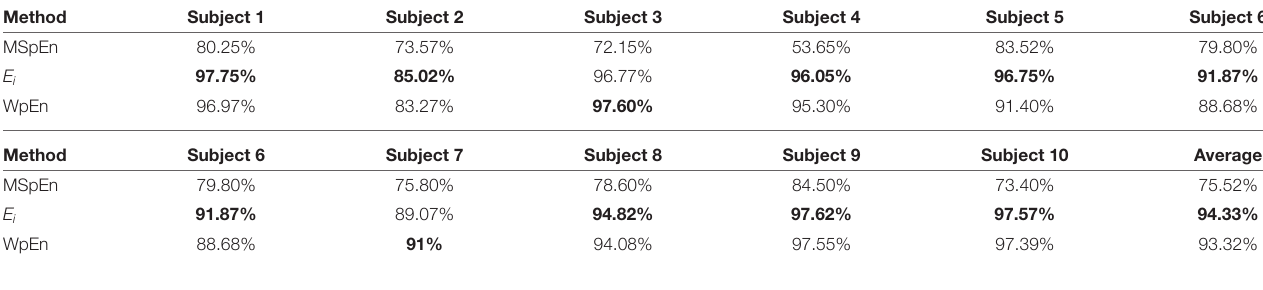
TABLE 2 | Average results of decision tree algorithm with multi-scale sample entropy (MSpEn), wavelet packet entropy (WpEn), and wavelet packet energy ( E i ).